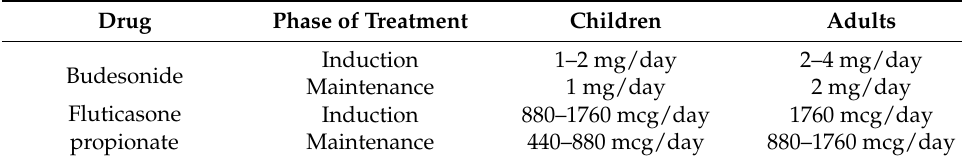
Table 1. Doses of STS recommended in